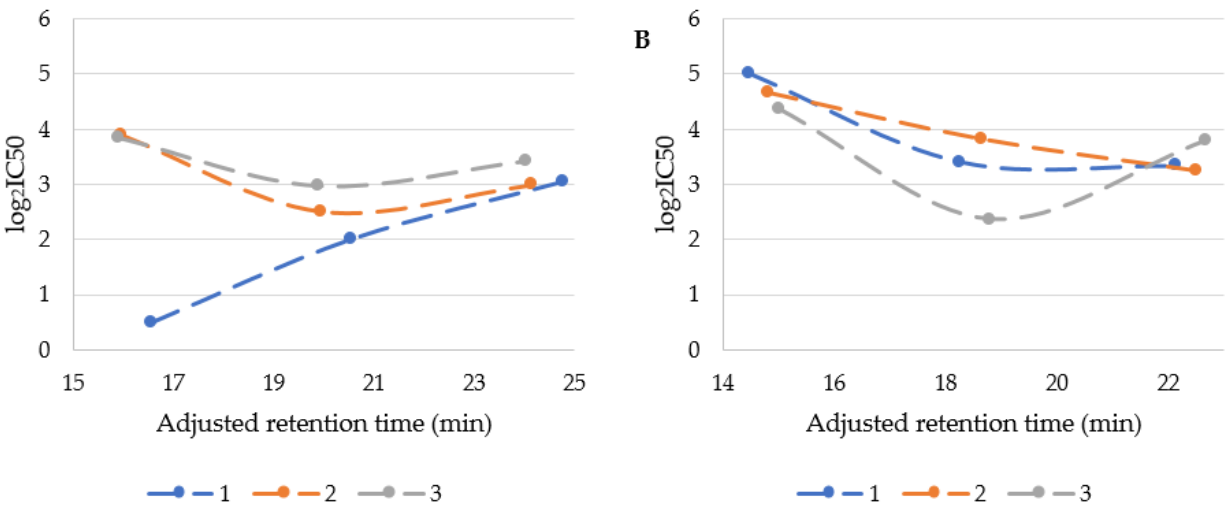
Figure 3. Cytotoxicity (log 2 IC 50 ) of USCLs ( A ) and gUSCLs ( B ) vs. the adjusted retention time.